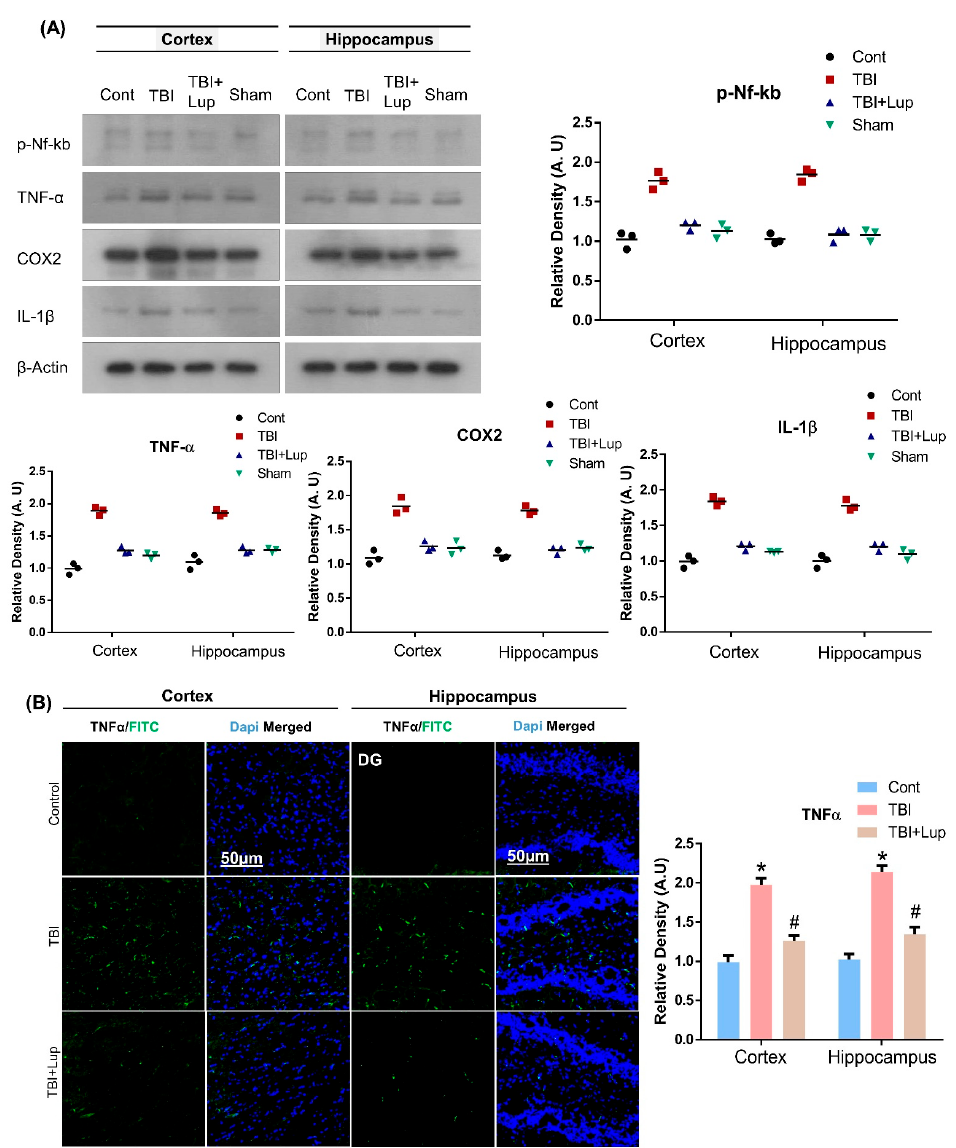
Figure 3. Lupeol alleviates the expression of p-NF-kB and inflammatory cytokines in TBI-treated mouse brain: ( A ) Western blot analysis of p-NF-kB, TNF- α , COX2, and IL-1 β expression in the cortex and hippocampus of mouse; ( B ) immunofluorescence analysis of TNF- α immunoreactivity (FITC—green), stained with DAPI (blue) in the cortex and DG region of hippocampus in different experimental mice groups. The cropped bands were quantified using Image software, and the differences are represented in the histogram. Asterisk (*) sign indicates significant difference from the normal saline-treated group; hash (#) sign indicates significant difference from the TBI-treated group. Bar = 50 µ m. The density values are expressed in arbitrary units as the mean ± SEM of the indicated proteins ( n = 6 animals per group). Significance = p ≤